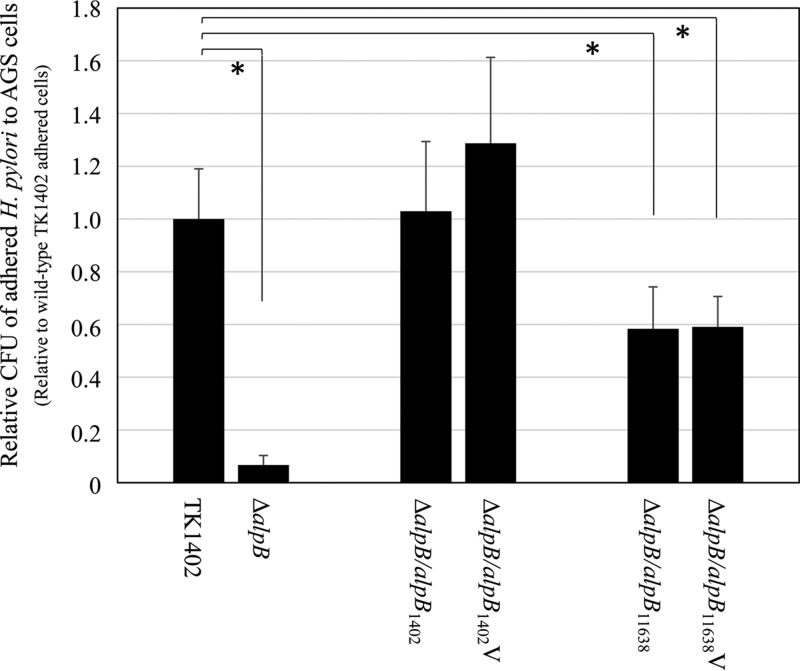
Adherence of H. pylori TK1402 wild type, the TK1402ΔalpB mutant strain (ΔalpB), and the restored strains to AGS cells. Intact alpB or the variable region of alpB from strain TK1402 or NCTC11638 was restored in the TK1402ΔalpB strain, and the adherence of the resulting strains (TK1402ΔalpB/alpB1402, TK1402ΔalpB/alpB1402V, TK1402ΔalpB/alpB11638, and TK1402ΔalpB/alpB11638V) to AGS cells was analyzed with CFU counts. All of the results were expressed as the means ± 1 standard deviation from at least three independent experiments. An asterisk indicates significant difference (P < 0.05) relative to the level of the wild type.